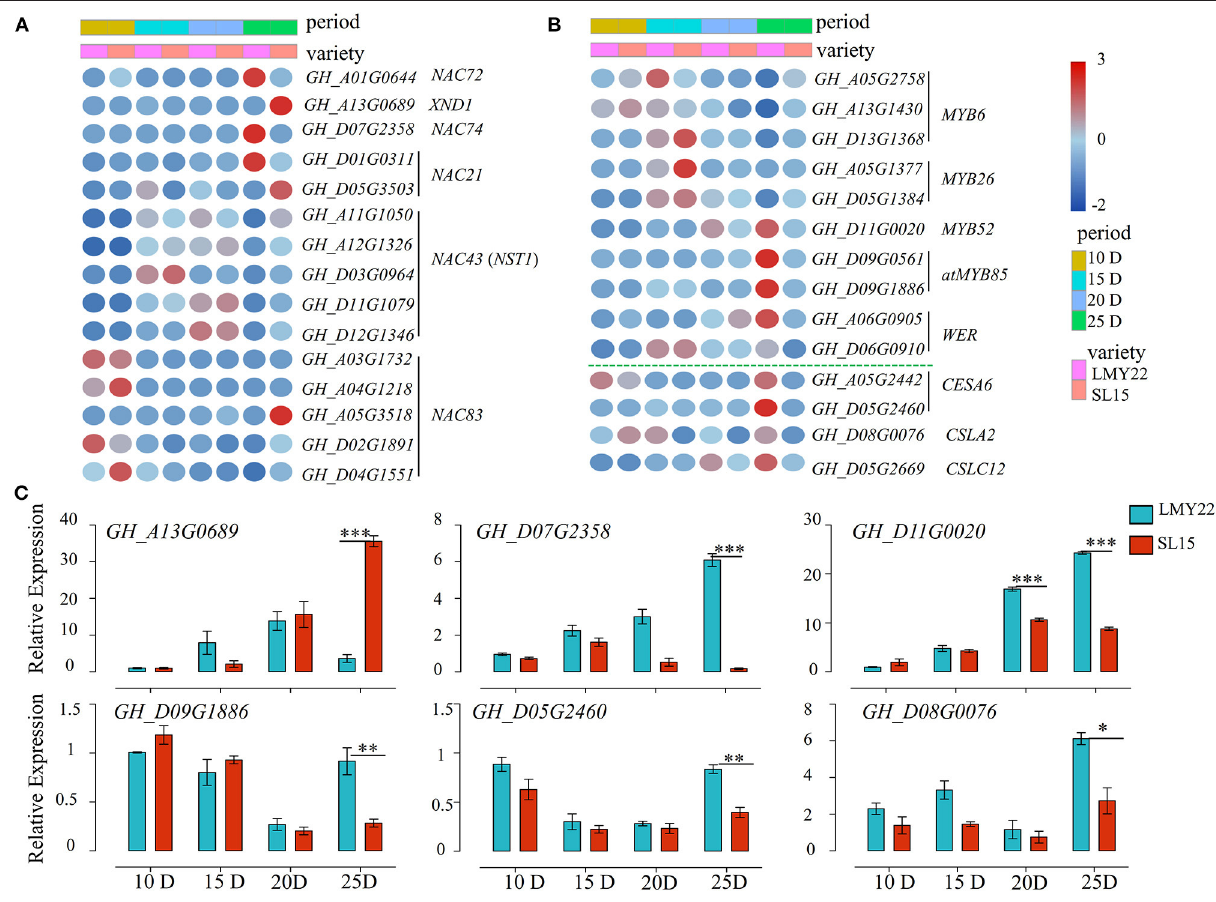
FIGURE 5 | Expression patterns of genes in the NAC-MYB-CESA network. (A) Heat map for DEGs encoding NAC transcription factors. (B) Heat map for DEGs encoding MYB-like transcription factors and cellulose synthase/synthase-like genes. (C) Expression of six DEGs as determined by qRT-PCR. * P < 0.05, ** P < 0.01, and *** P <